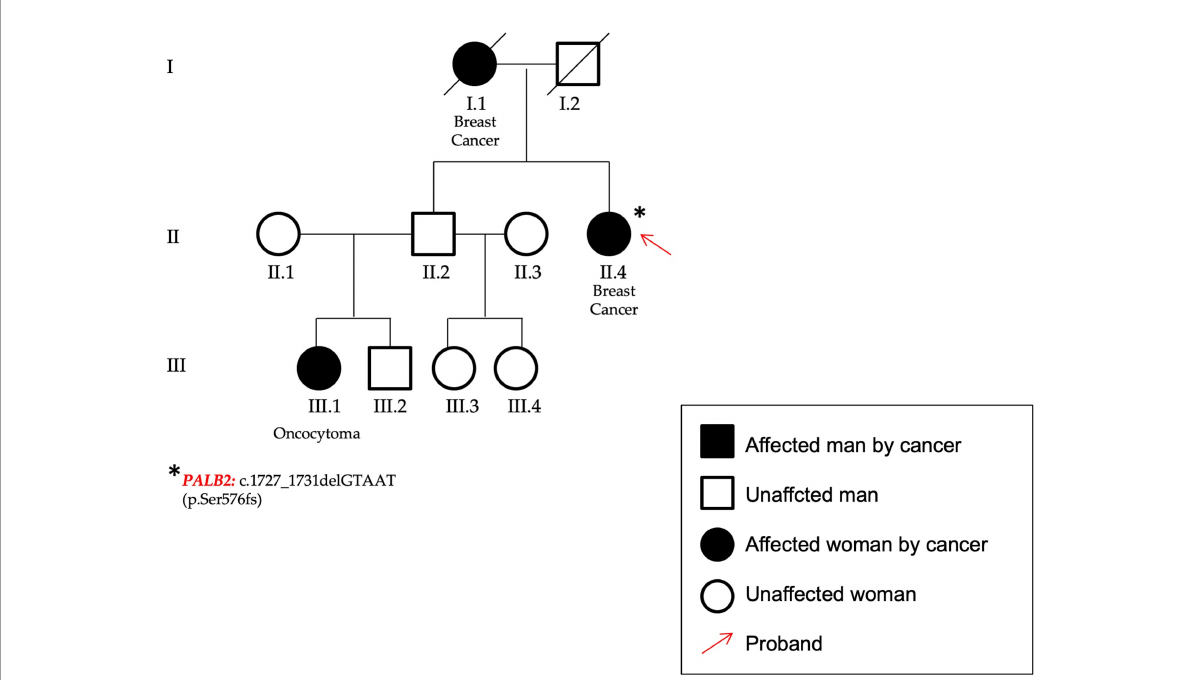
FIGURE5 In figure the pedigree of P59. The patient (identified by a red arrow) affected by breast cancer showed a frameshift variant in PALB2